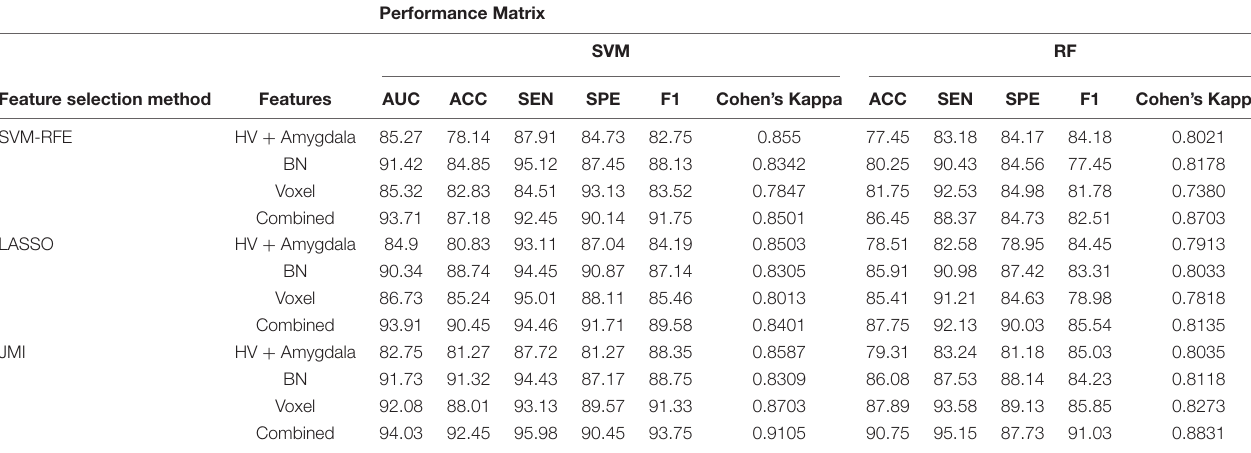
TABLE 3 | A 10-fold cross-validated binary classification performance for AD vs. mild cognitive impairment (MCI) groups using SVM and RF classifiers. Performance Matrix SVM